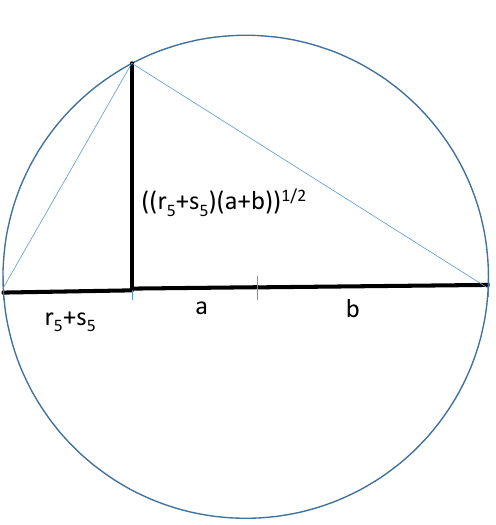
Figure 9: Geometric construction of p ( r 5 + r 6 )( a + b ) . 16